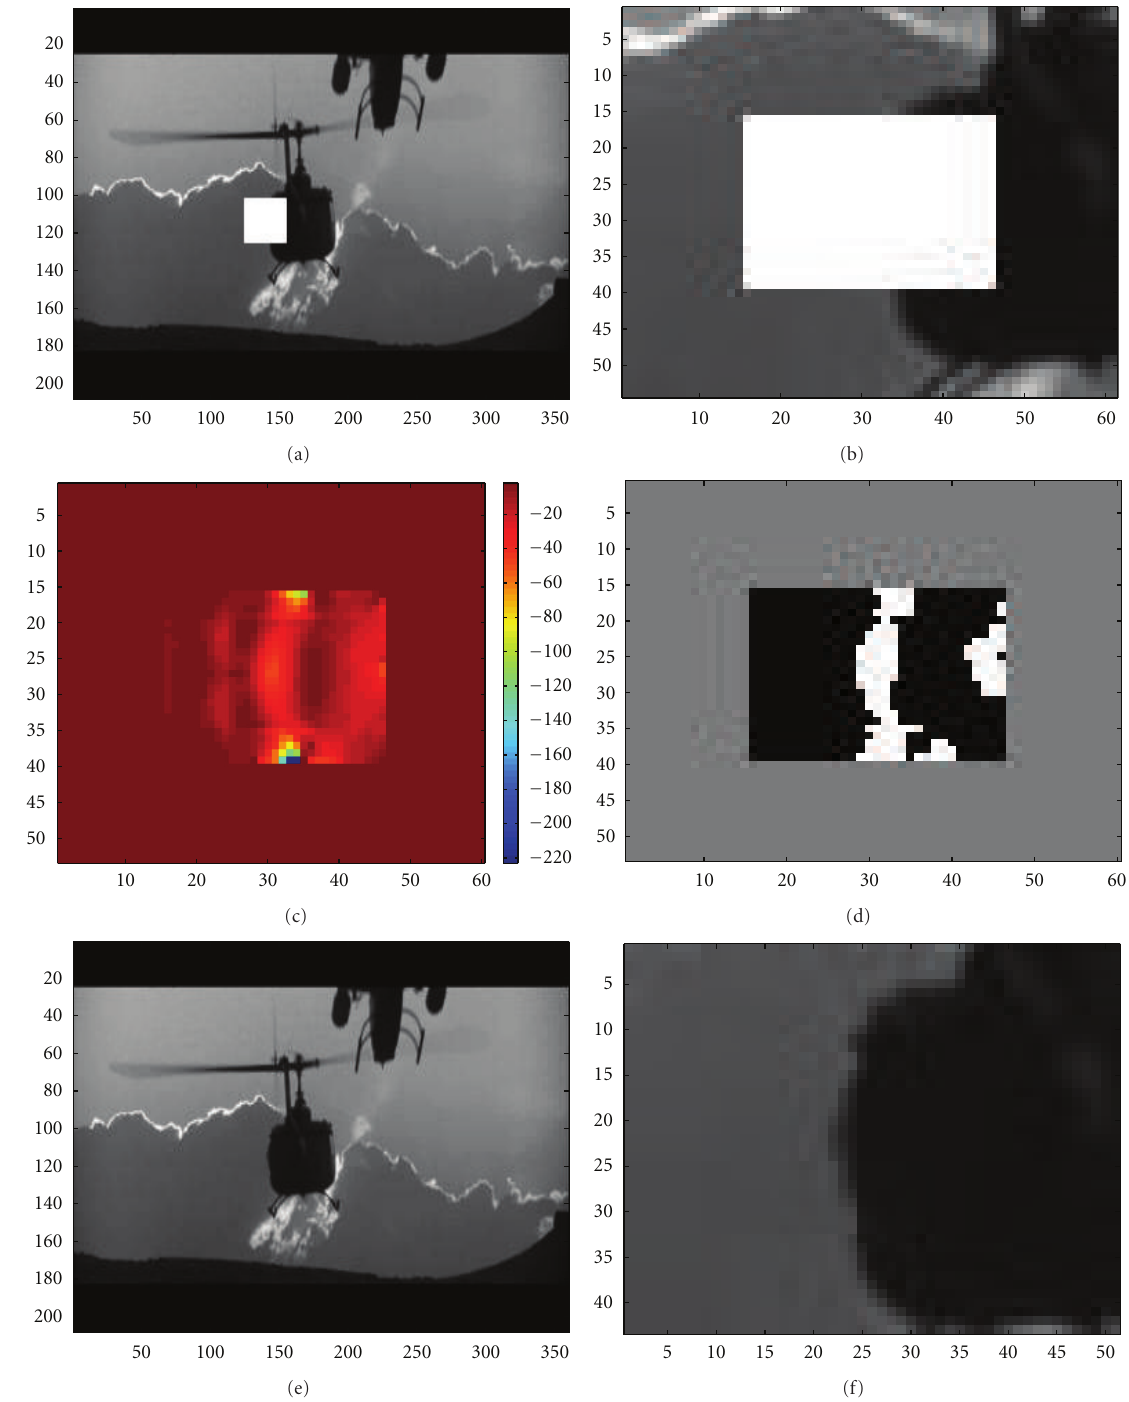
Figure 5: (a) Occluded image (by a white rectangle); (b) Zoom of the occluded zone (see (a)); (c) Topological gradient of (b); (d) Identified edges in the occluded zone by thresholding the topological gradient; (e) Inpainted image using the topological gradient; (f) Zoom of the occluded zone (see